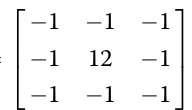
dermal cells show line-shape darkness (where the opaque defect lies) with the blurred and unresolved boundaries between the two cells. In Fig. 3m, our meta-imager creates the defect-free long-axis edges of the cells, meanwhile eliminating short-axis edges that are nearly parallel to the differentiation direction. Experimentally, the short-axis